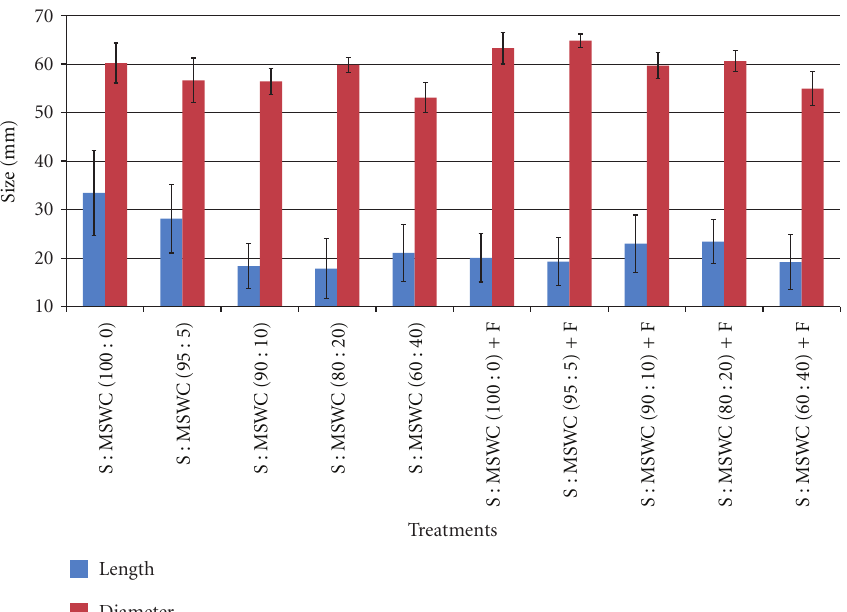
Figure 6: E ff ects of municipal solid waste compost (MSWC) into soil (S) without or with fertigation (F) on fruit size (length and diameter in mm) of greenhouse pepper crop. Values represent mean ( ± SE) of measurements made on average 23 fruits per treatment.